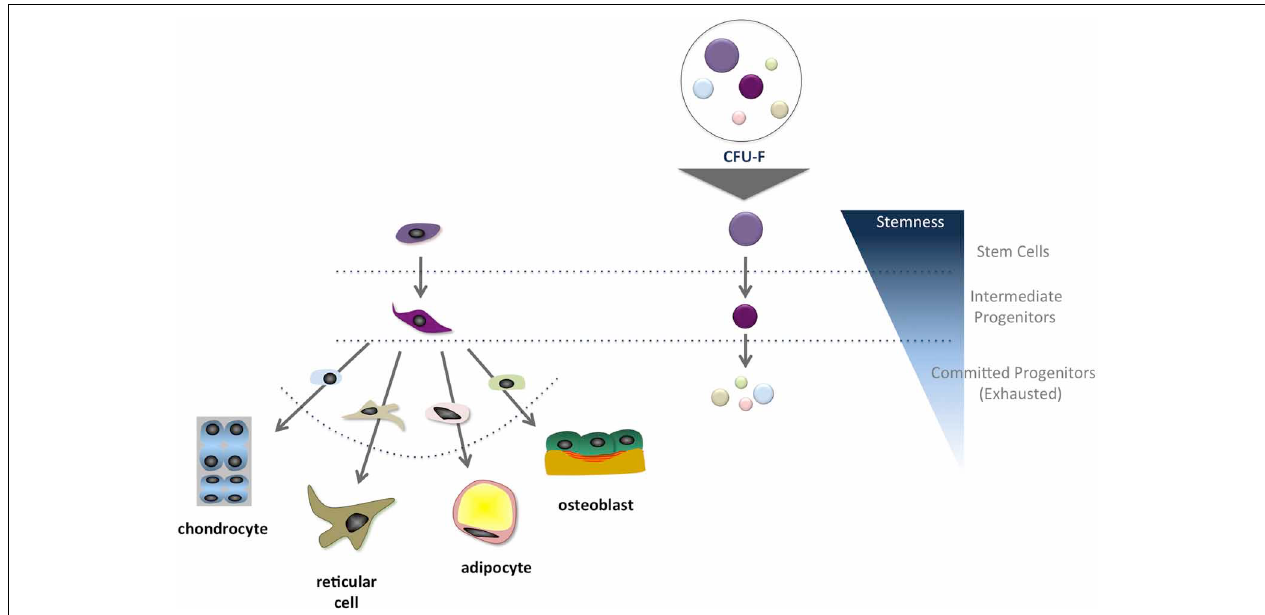
FIGURE 1 | Schematic representation of the suggested correlation between the mesenchymal stem cell differentiation cascade and colony size in vitro . It is frequently inferred that most primitive progenitors give rise to larger colonies compared to those originated from intermediate and committed progenitors.